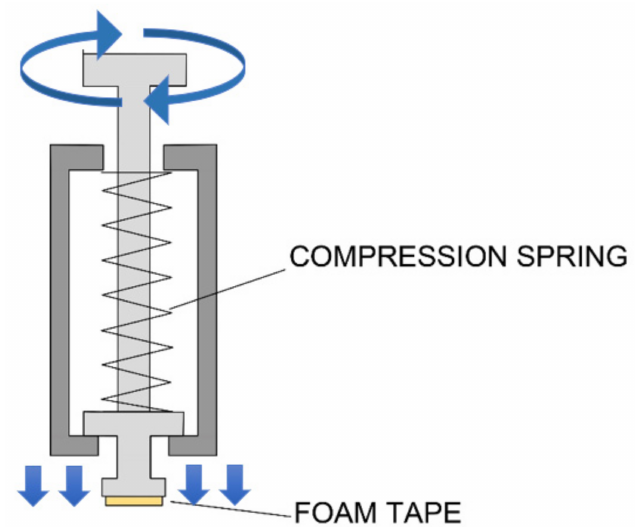
Figure 1. Spring instrument for measuring the decohesion degree of the paint